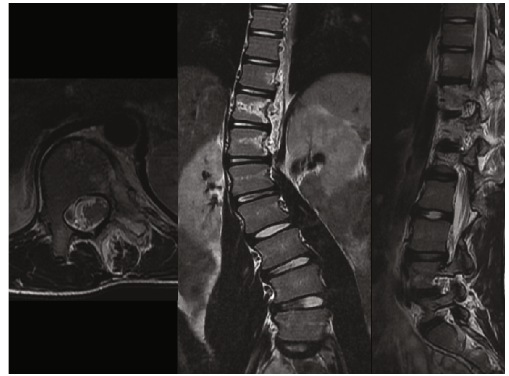
Figure 4: MRI scan at the time of surgical intervention decision. (a) Axial view of T11 vertebral body level. Left side of vertebral body, pedicle, and paravertebral musculature are involved with the tumor. (b) Coronal view. The tumor is located on the left sides of T10 – T12 vertebrae, while T11 vertebral body is the most a ff ected by the tumor. (c) Sagittal view. The tumor is dispersed among T11 and T12 vertebral bodies, passing the pedicles, extending to the